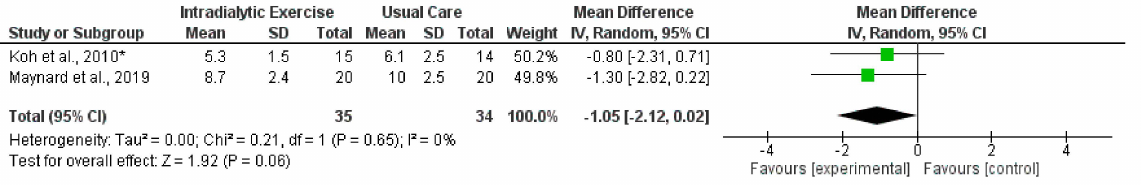
Figure 11. Effect of intradialytic exercise on timed-up-and-go score (s) in individuals receiving haemodialysis. Data are expressed as mean difference and 95% CI. * Data for exercise and control groups only